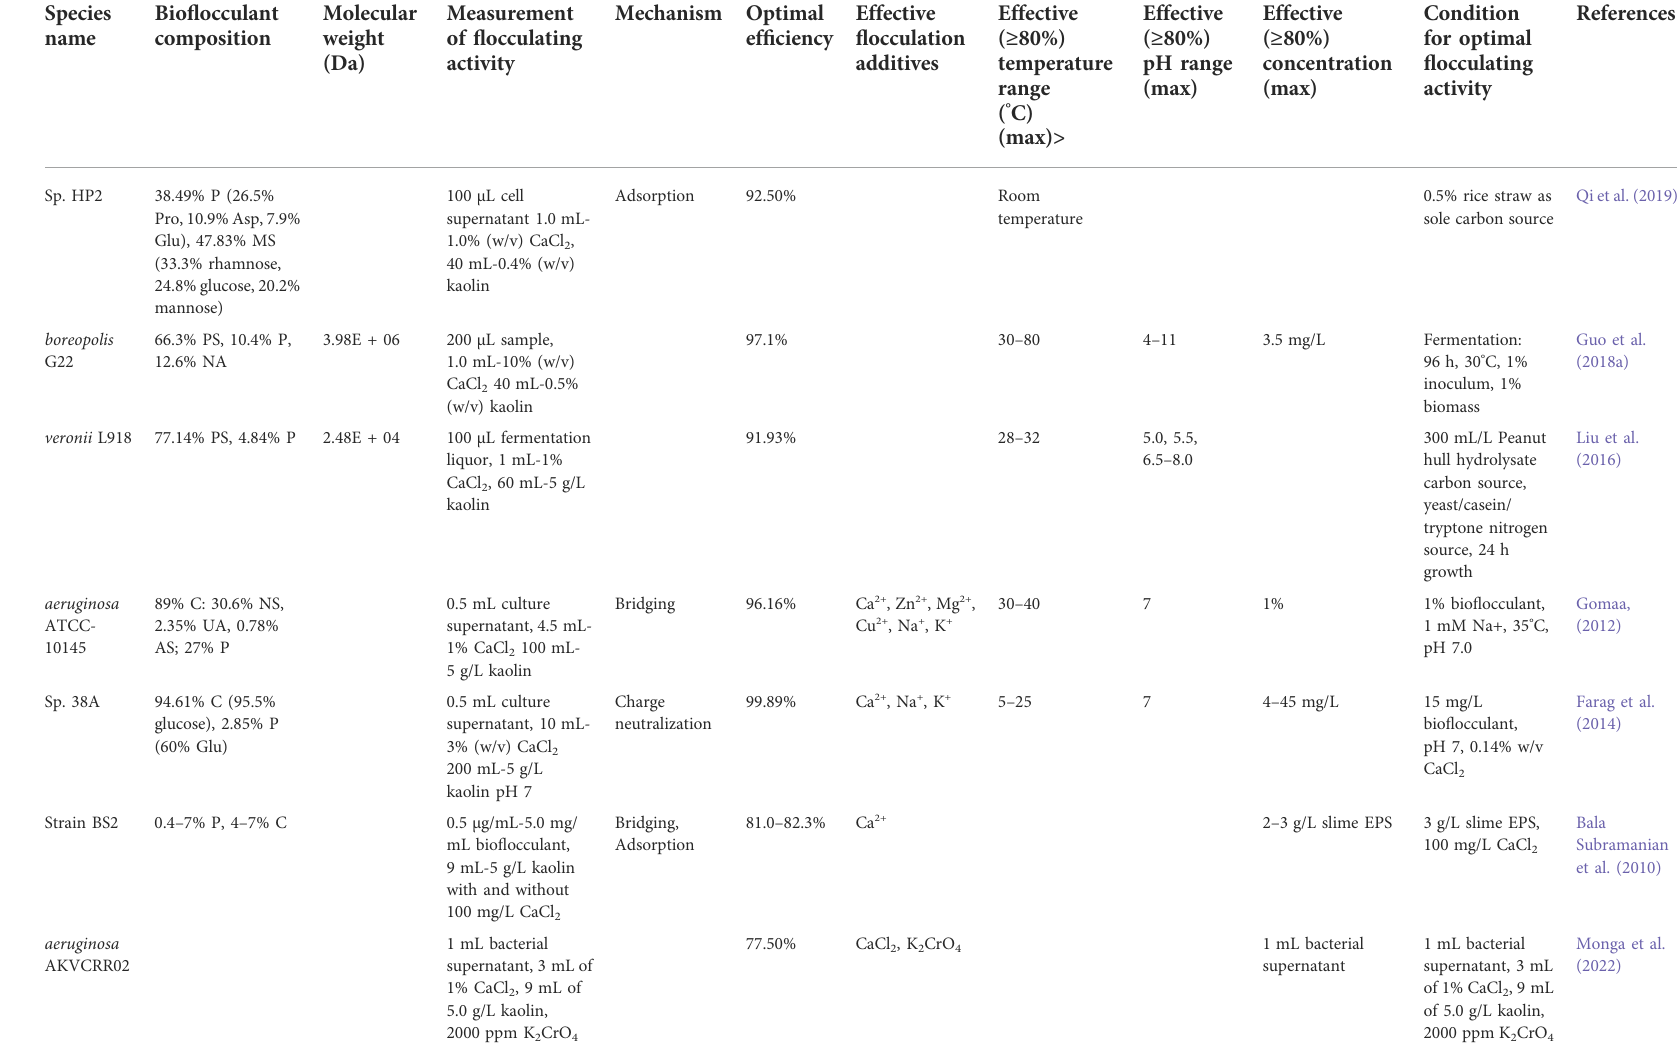
TABLE 2 Pseudomonas genera and their bio fl occulation